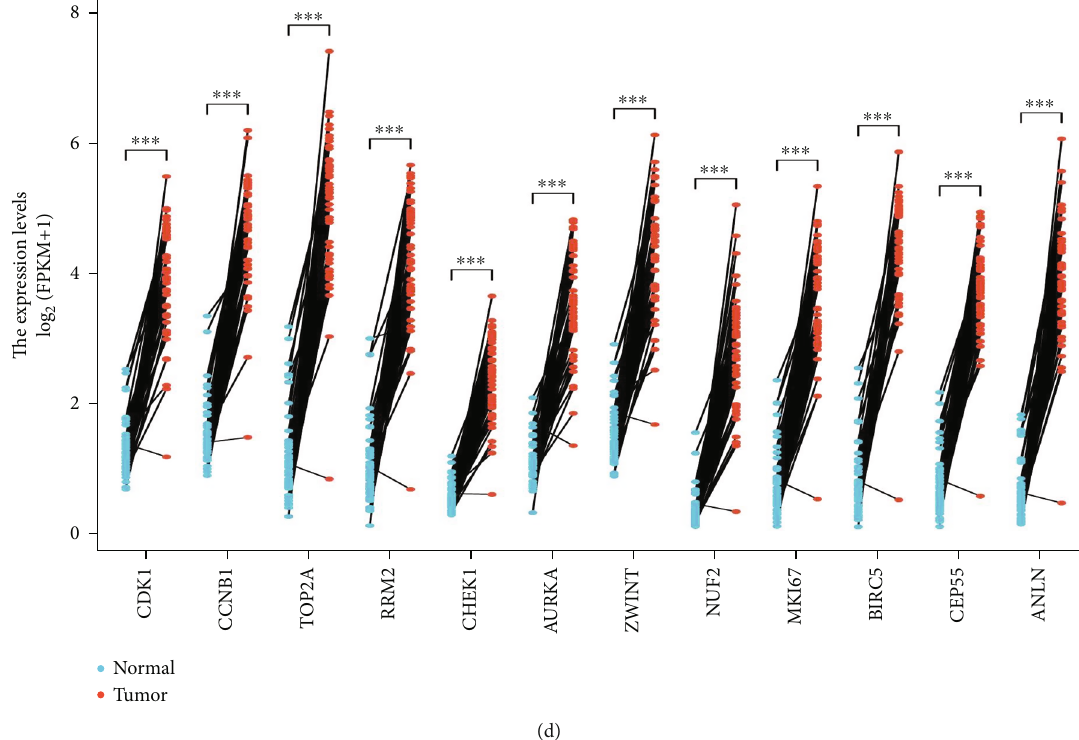
Figure 2: The 12 hub genes were used to draw the di ff erence in the distribution of lung adenocarcinoma and lung squamous cell carcinoma tissues and adjacent tissues in the TCGA (https://portal.gdc.cancer.gov/) database using ggplot2 in R language. (a) is the expression of hub gene in cancer tissues and adjacent tissues of unpaired samples in LUAD, and (b) is the expression of hub gene in cancer tissues and adjacent tissues of unpaired samples in LUSD. (c) represents the expression of hub gene in LUAD paired sample cancer tissues and adjacent tissues, and (d) represents the expression of hub gene in LUSD paired sample cancer tissues and adjacent tissues. The P value adopts scienti fi c notation and all have statistical signi fi cance. ∗ P < 0 : 05 ; ∗∗ P < 0 : 01 ; and ∗∗∗ P < 0 : 001